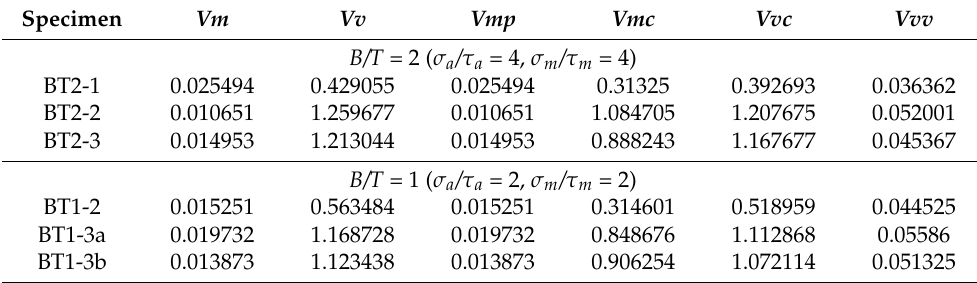
Table 7. Summary of the Vx